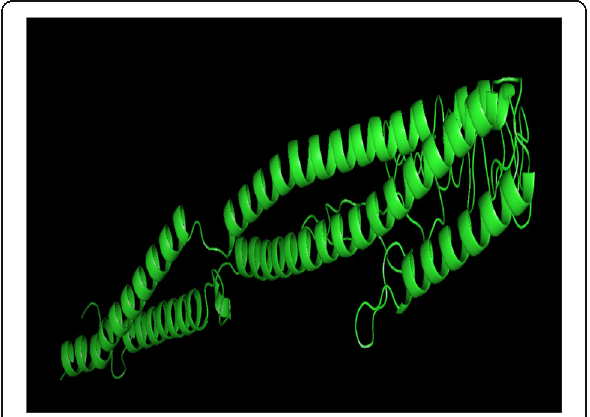
Fig. 4 The 3D structure of vaccine